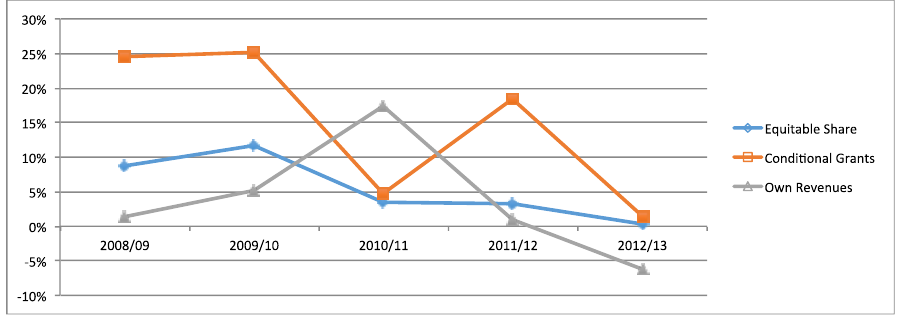
FIGURE 3: Real growth in provincial revenue instruments - Post-crisis (%) Source: National Treasury